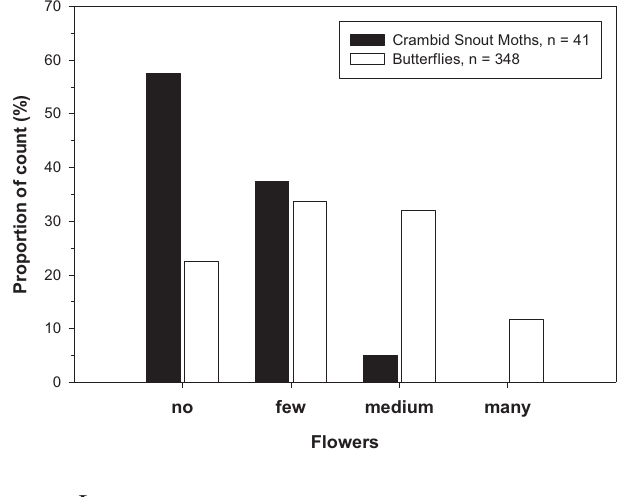
Figure 1. Relationship between flowering aspect and occurrence of butterflies and Crambid Snout Moths in the region South Upper-Rhine. Given is the respective proportion (%) of each count in relation to the number of flowers present in the field margins.